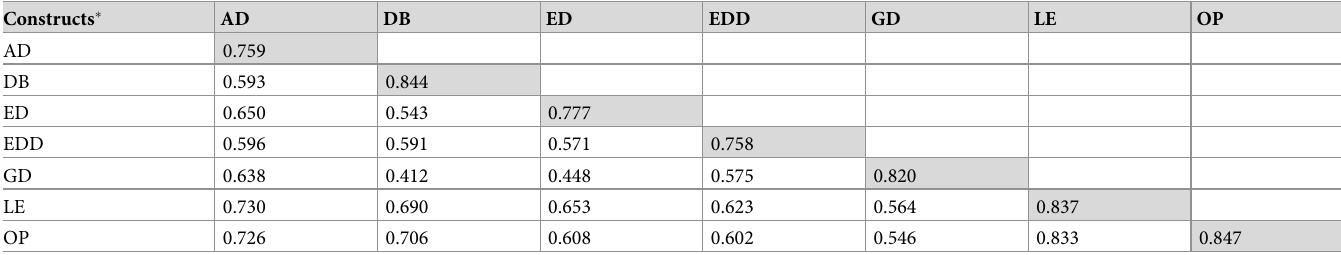
Table 3. Square roots of